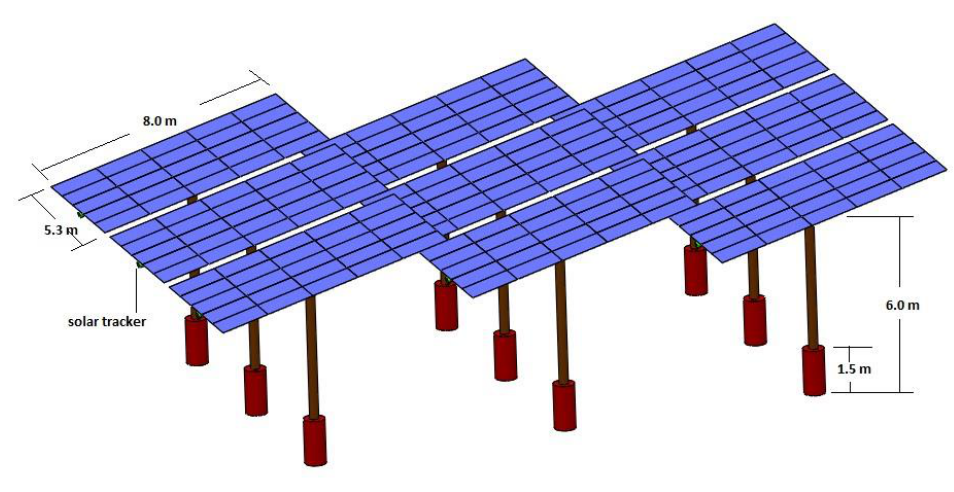
Figure 3. Solar PV Array Arrangement